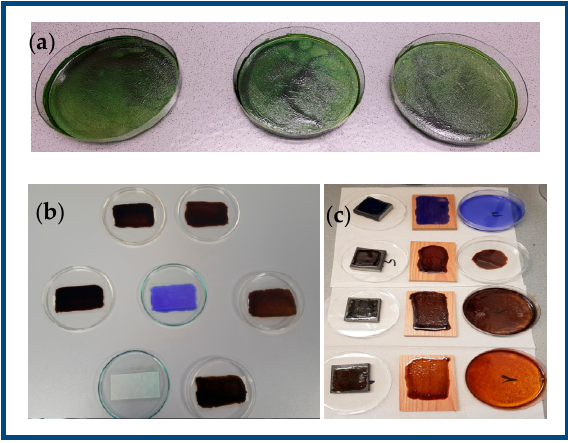
Figure 6. ( a ) Three lignin–PU coatings with brilliant green as antimicrobial additive; ( b ) lignin–PU